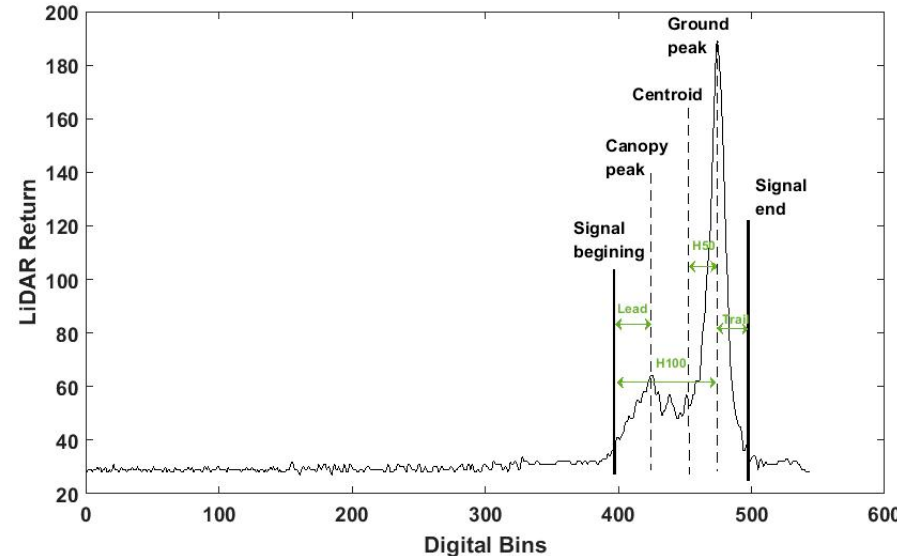
Figure 2. A typical waveform profile of a GLAS shot in Maryland.